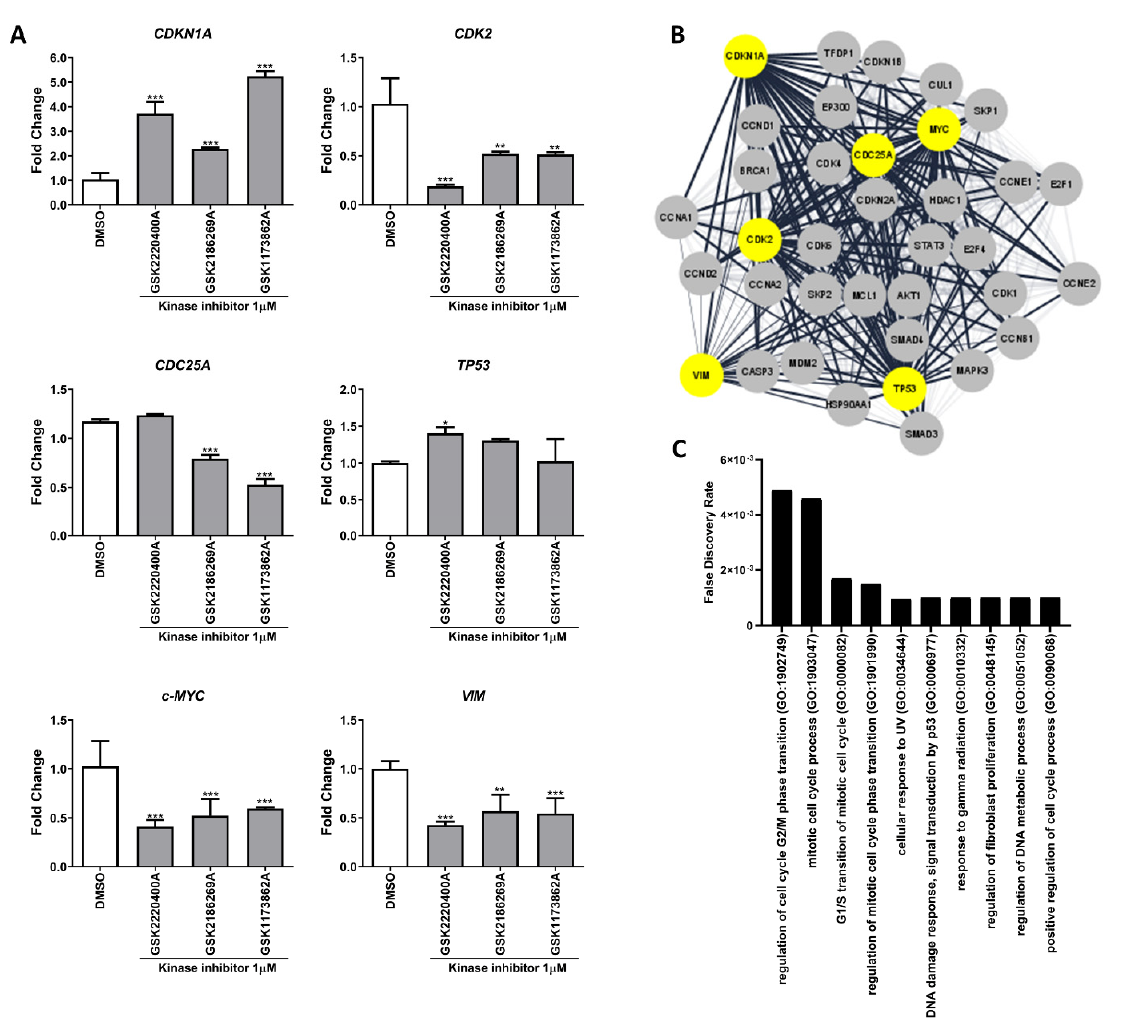
Figure 3. Gene expression pattern of oncogenes and tumor suppressors genes in metastatic gastric cancer cells after kinase inhibitors treatment (1 µM). ( A ) Mean ± standard deviation of mRNA expression fold change of CDK1NA , CDK2 , CDC25A , TP53 , c-MYC, and VIM after KI exposure. ( B ) Protein–protein interaction network analysis of the modulated genes after kinase inhibitor treat- ment. Analyzed genes by RT-qPCR after treatment are represented with yellow color. ( C ) False Dis- covery Rate (FDR) of functional analysis with GO biological processes gene set. The top 10 GO pro- cesses are sorted by the FDR. Significant differences compared to the untreated control: * p < 0.05, ** p < 0.01, *** p < 0.001.